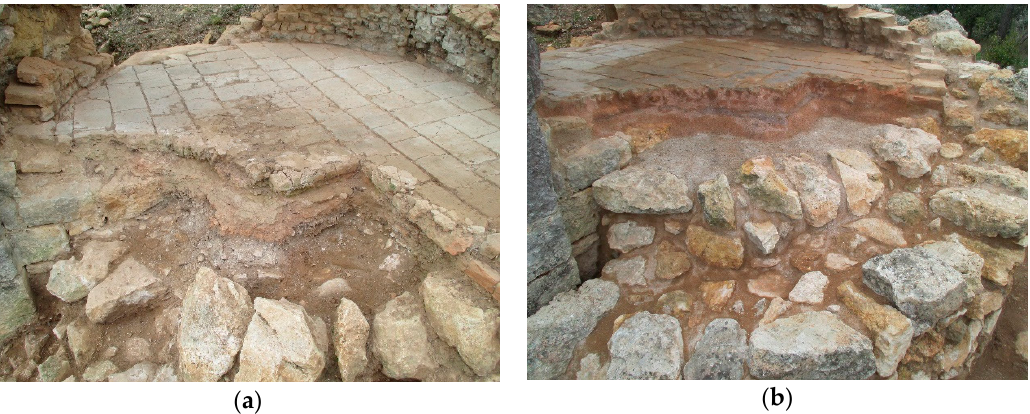
Figure A2. Sant Llorenç de la Senabre’s domestic oven after the completion of the excavation in 2012 ( a ) and its restoration in 2016 ( b ).